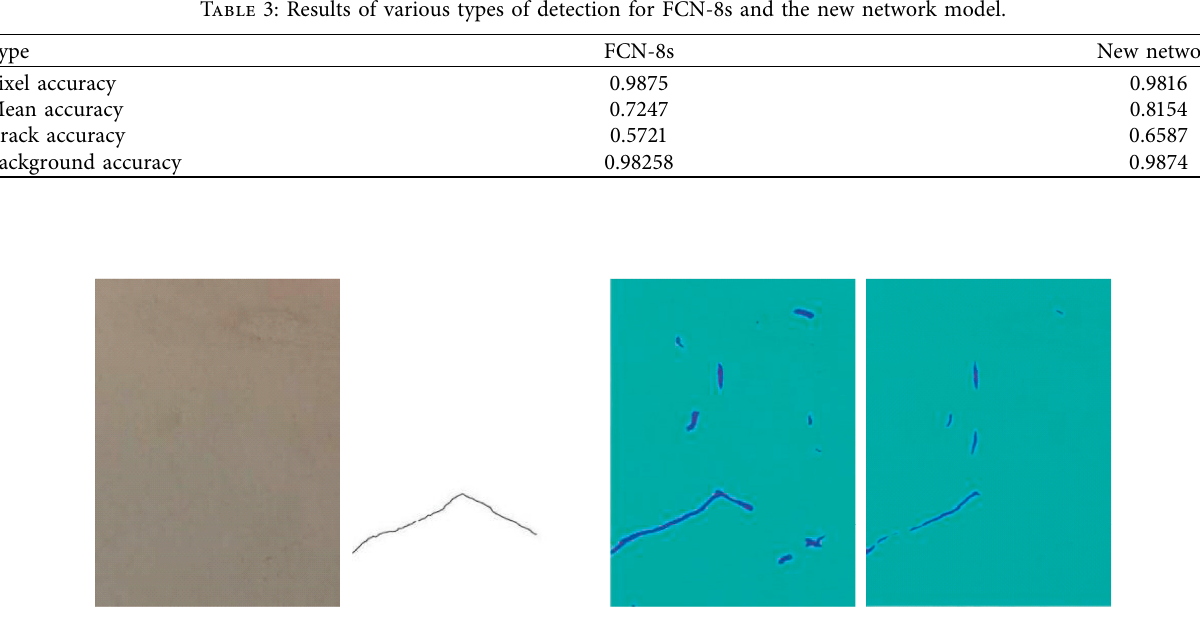
Figure 9: FCN-8s and new network detection results.